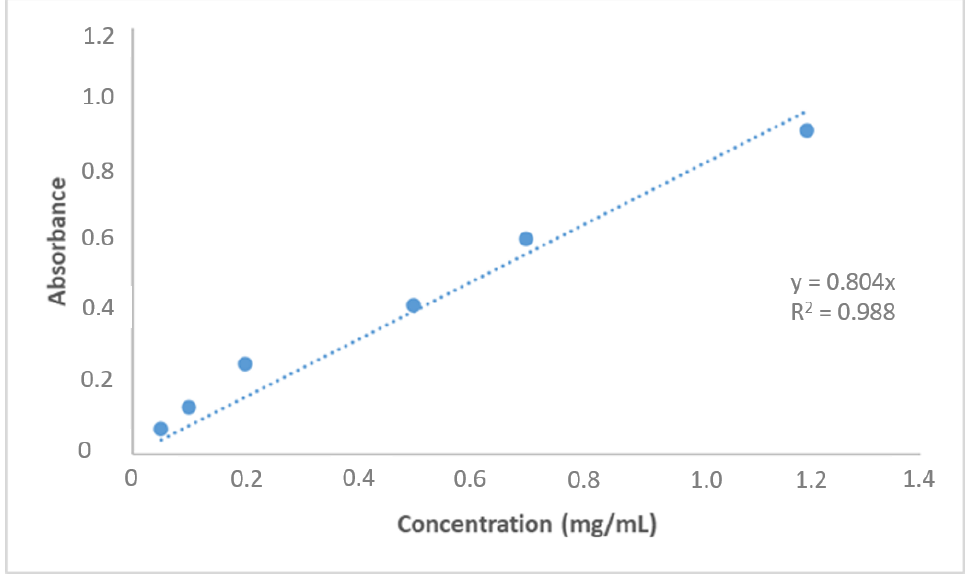
Figure 5. The standard curve for the detection of amlodipine.